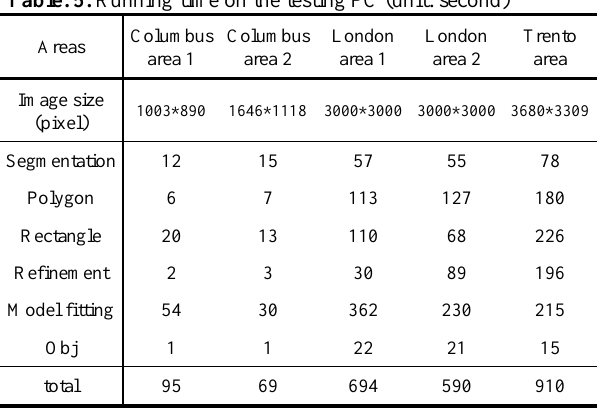
Table. 5. Running time on the testing PC (unit: second)